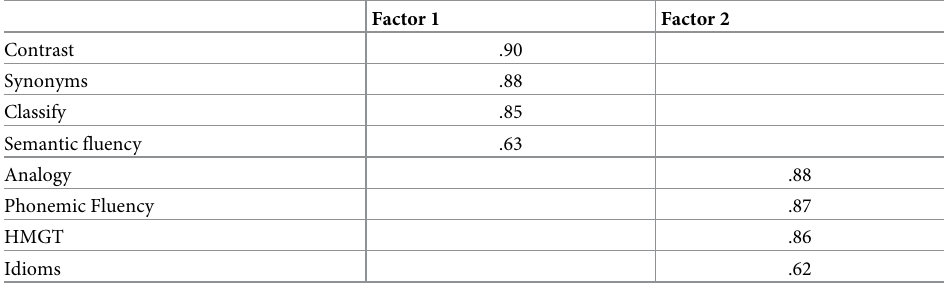
Table 1. Rotated component matrix of confirmatory factor analysis on the different Hebrew verbal tests. Factor